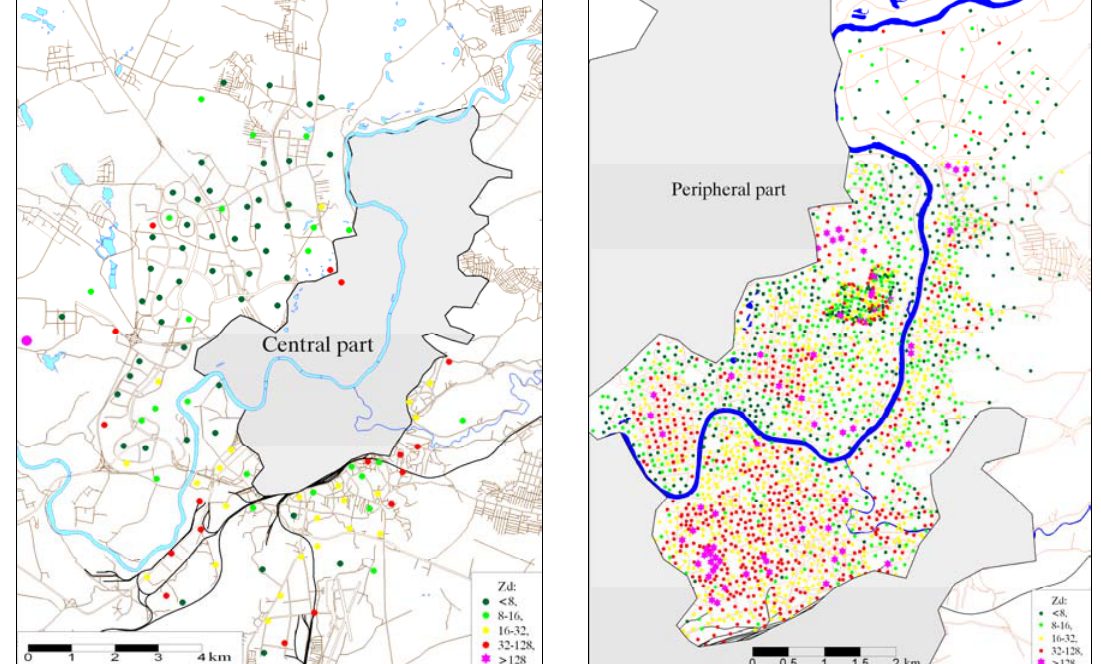
Fig. 2. Additive index Zd of topsoil contamination by Ag, B, Ba, Co, Cr, Cu, Mo, Ni, Pb, Sn, Sr, V, Zn in urbanized core of Vilnius city (peripheral part is on the left figure and central part – on the right figure) Legend: 1 ≤ Zd ≤ 8 – very low (allowable lower) contamination, 8 < Zd ≤ 16 – low (allowable higher) contamination, 16 < Zd ≤ 32 – medium (medium dangerous) con- tamination, 32 < Zd ≤ 128 – high (dangerous) contamination, Zd > 128 – extremely high (extremely dangerous)